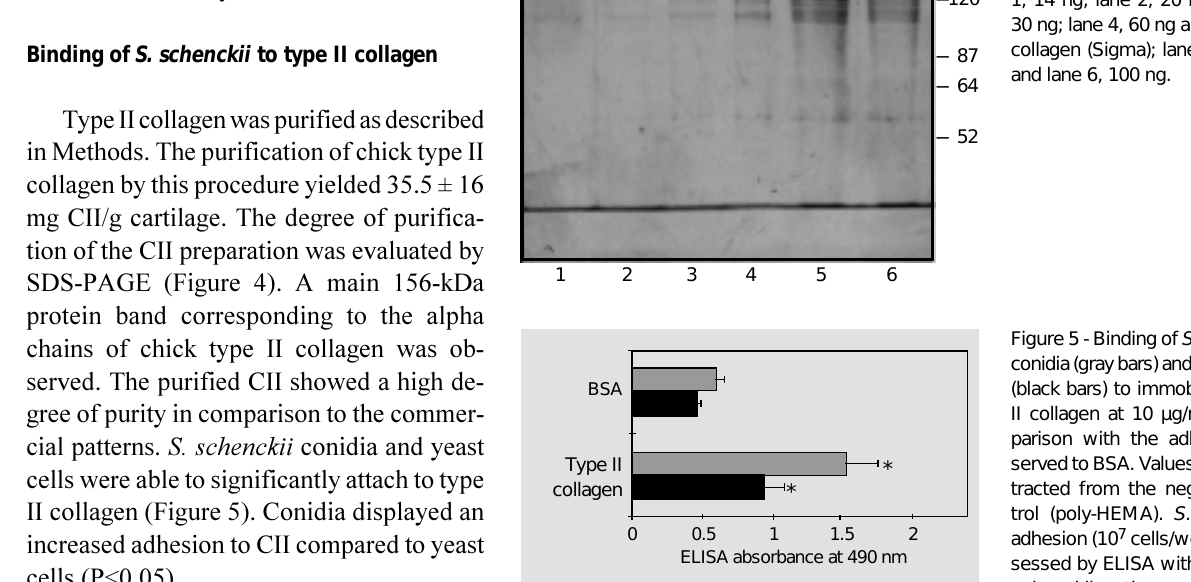
Figure 3 - Relative adhesion in- dex of S. schenckii yeast phase (black bars) and conidia (gray bars) to immobilized fibronectin and laminin. The adhesion index was calculated using the for- mula: A 490 to ECM protein/A 490 to BSA - A 490 with poly-HEMA (negative control). S . schenckii binding (10 7 cells/well) was as- sessed by ELISA with an anti- S. schenckii antiserum. *P<0.05 compared to yeast cells (Student t -test).